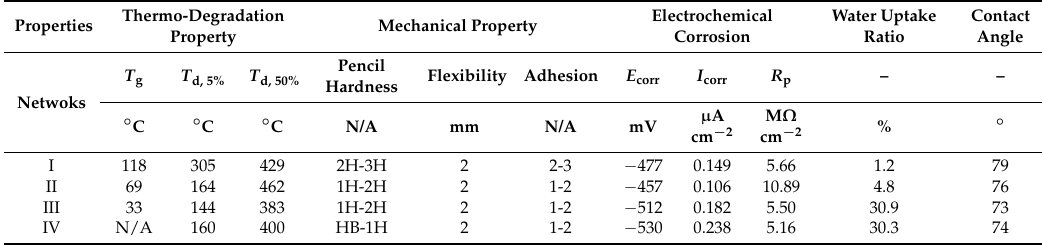
Figure 3. ( a ) DSC curves of the four networks after different heating runs; ( b ) measured or calculated gel content, swelling ratio, and crosslink density of the four networks, as well as images of the solubility of such networks in DMF after different treatment; ( c ) TGA curves of Network I to IV in an air flow. Table 1. Thermal, mechanical, and electrochemical corrosion properties of the four coatings.